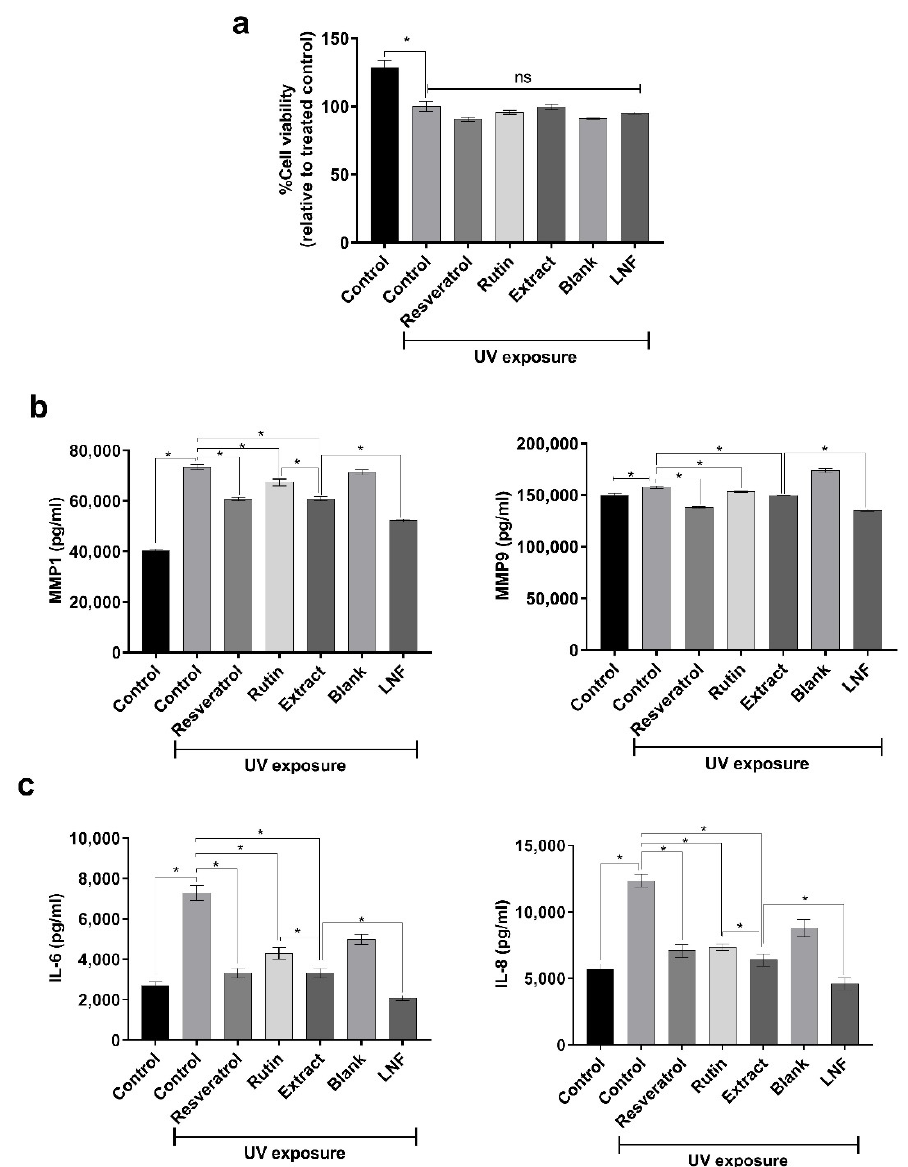
Figure 7. Inhibition of UV-induced MMPs and interleukin secretion on co-cultured skin cells by fenugreek extract and LNF: ( a ) Effect of UV-induced cytotoxicity after the pretreatments of resveratrol, rutin, fenugreek extract, blank nanoparticles (liponiosome without fenugreek extract), LNF nanoparticles, and 0.005% DMSO as a control (vehicle). HaCAT and human dermal fibroblast cells were co-cultured and pretreated with 7 µ g/mL of extract and 100 µ g/mL of LNF (7 µ g/mL of extract equivalence), together with 100 µ g/mL of blank, 10 µ g/mL of resveratrol, 7 µ g/mL of rutin as a positive, and 0.005% of DMSO as a control (vehicle), for 24 h before UV exposure. Data are means ± SD ( n = 3). *, p < 0.05. ( b ) The levels of UV-induced MMP1 and MMP9 secretions after fenugreek extract and LNF treatments. Data are reported as means ± SD ( n = 3). *, p < 0.05. ( c ) The levels of UV-induced IL-6 and IL-8 secretions after fenugreek extract and LNF treatments. Data are reported as means ± SD ( n = 3). *, p <